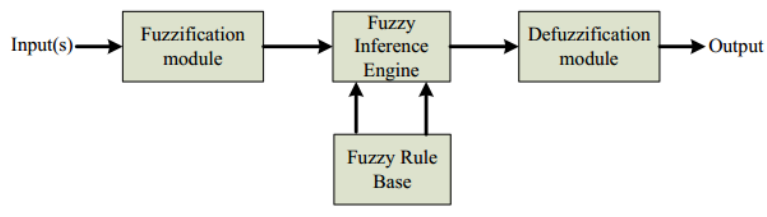
Figure 7. General block diagram for FL systems